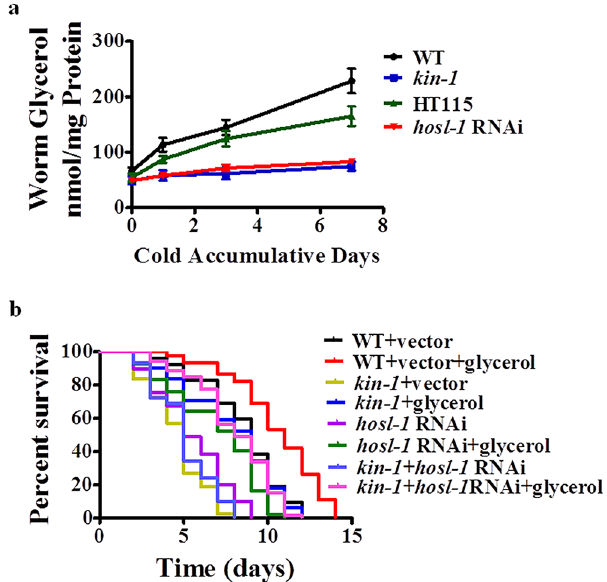
Figure 4. Glycerol accumulation is mediated by KIN-1 and HOSL-1. ( a ) The glycerol contents were elevated after 1, 3, and 7 days of cold exposure in wild type (WT) worms. The mutation in kin-1 ( ok338 ) or hosl-1 ( RNAi ) inhibited the glycerol accumulation. These results are means ± SD of four experiments. ( b ) Addition of glycerol (5 mM) not only recovered the resistance to cold stress in kin-1 ( ok338 ) or hosl-1 ( RNAi ) worms, but also enhanced the resistance to cold stress in wild type worms. P < 0.01 relative to WT.